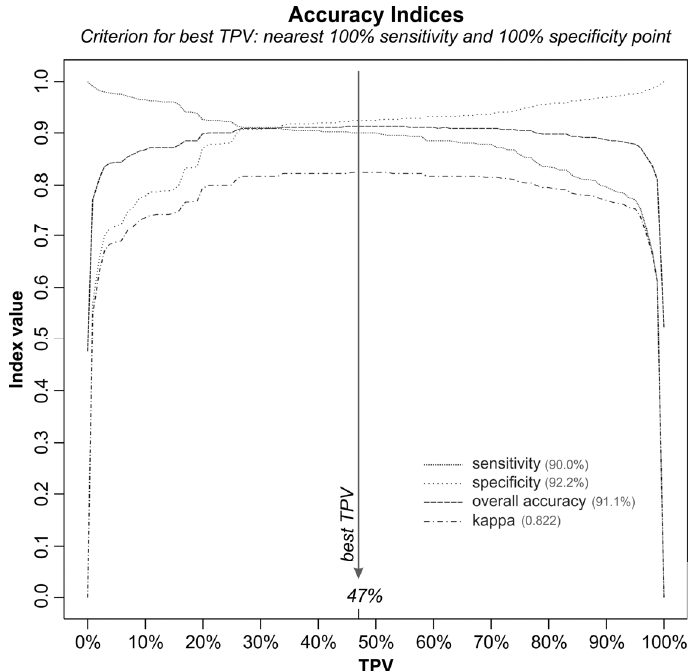
Figure 12. Accuracy indices associated with thematic maps generated from the Probability Image (PI) by varying the Target Probability Value (TPV) from 0% to 100%. The vertical line identifies the best TPV, according to the chosen criterion, highlighting the accuracy achieved according to each index (described in the